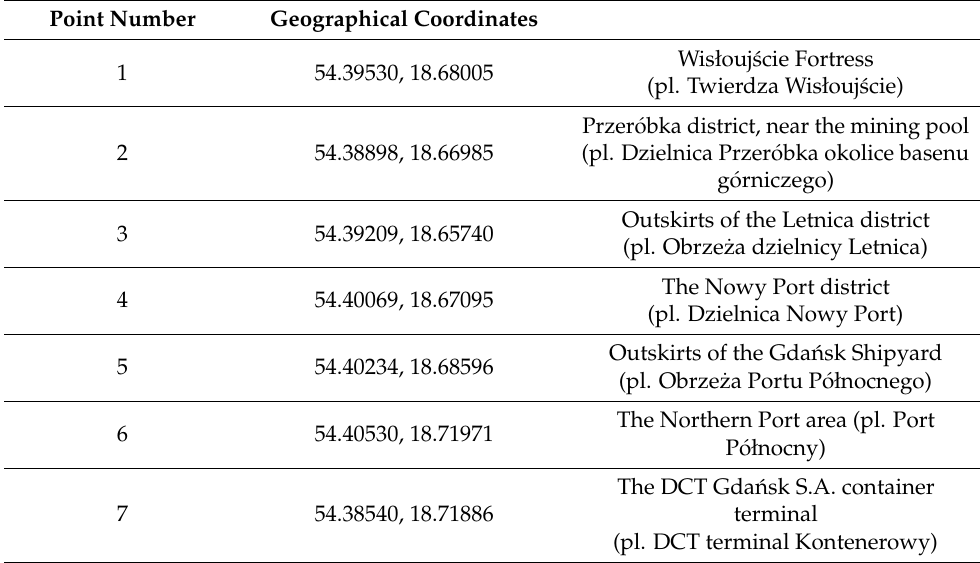
Figure 5. An example of radiance levels based on a selected year and point within the Wisłouj´scie Fortress area, with the help of the “Point information tool” from the LPM web portal. Source: authors’ elaboration based on the graphics displayed by the LPM service. Table 1. Geographical coordinates of the seven analysed points. Source: authors’